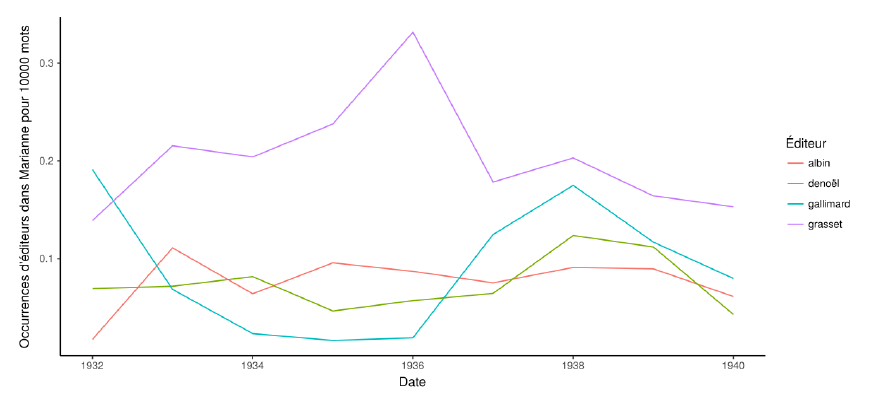
Nombre d’occurrences des termes Gallimard et La NRf pour 1000 mots dans le journal Marianne